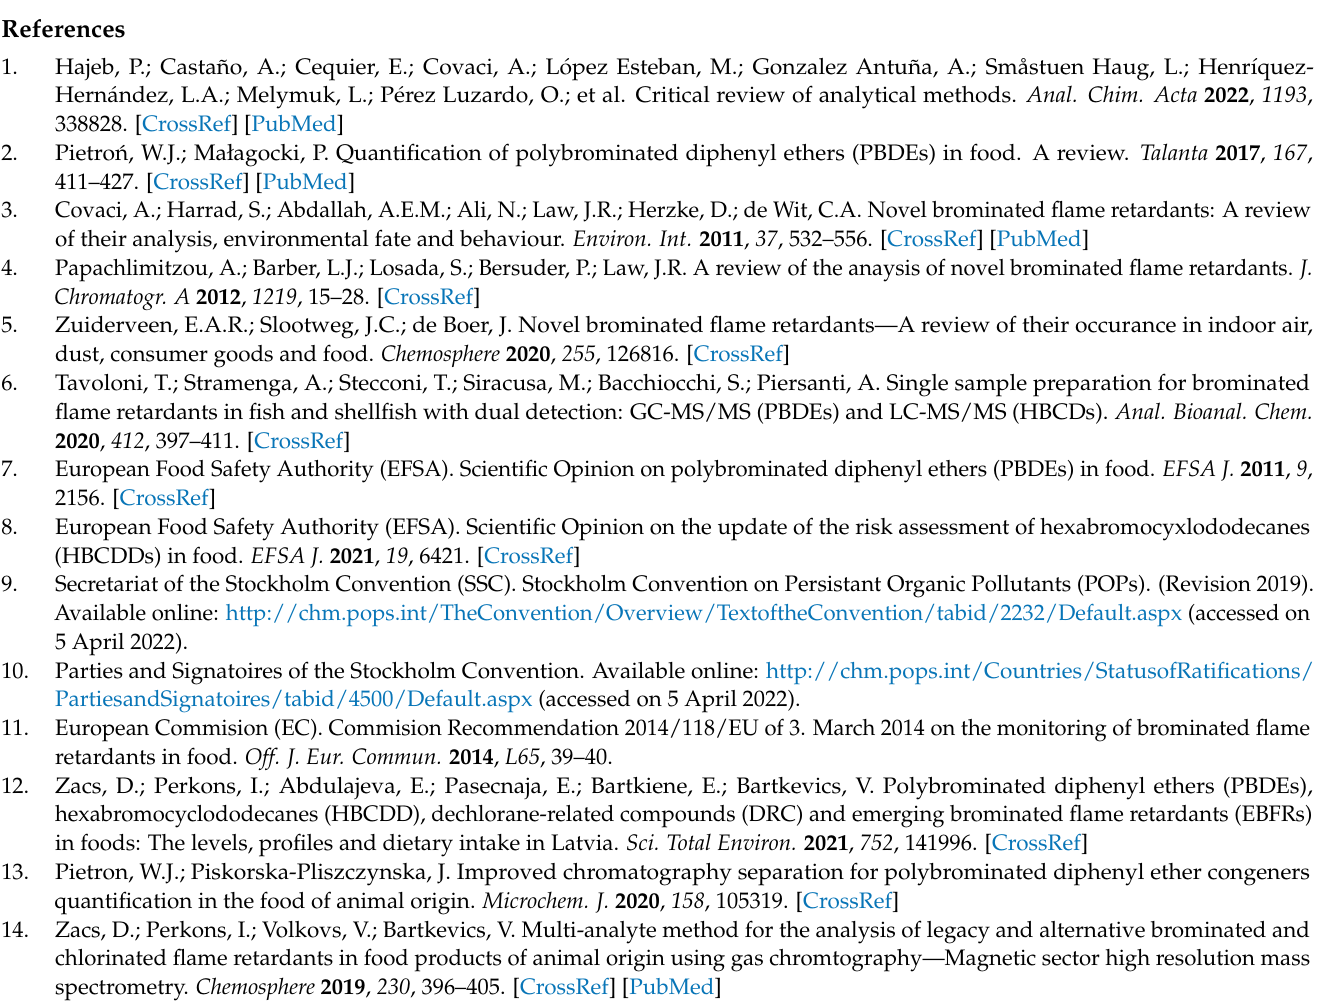
(BDE-209); Figure S6: LC-MS/MS (ESI) chromatogram of extract of infant milk formula, fortified at 0.01 µ g/kg of BDE-28 to BDE-183, 0.01 µ g/kg of α -, β - and - γ HBCDD and 0.1 µ g/kg of